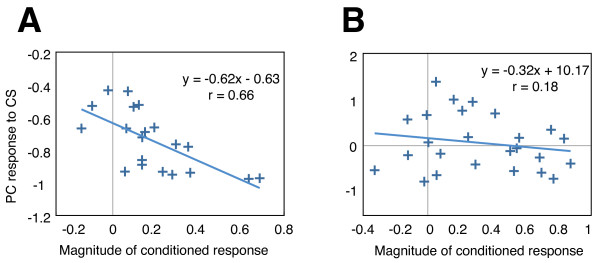
Relationship between magnitudes of conditioned responses and PC responses during the first 2 s of CS presentations in the acquisition sessions.A. Representative data from a fish that showed an significant correlation (p = 0.002) between the conditioned response magnitude and the level of suppression of PC activity during the CS. B. Representative data from a fish that did not show a correlation between the magnitude of the conditioned response and the response of the PC to the CS. The vertical axes show relative spike frequencies of the PCs relative to the frequencies in the 2 s before the CS. Inhibitory responses of the PCs to the CS were assigned negative values. Formulae of the linear regressions and r-values were also shown. PC: Purkinje cell; CS: conditioned stimulus.